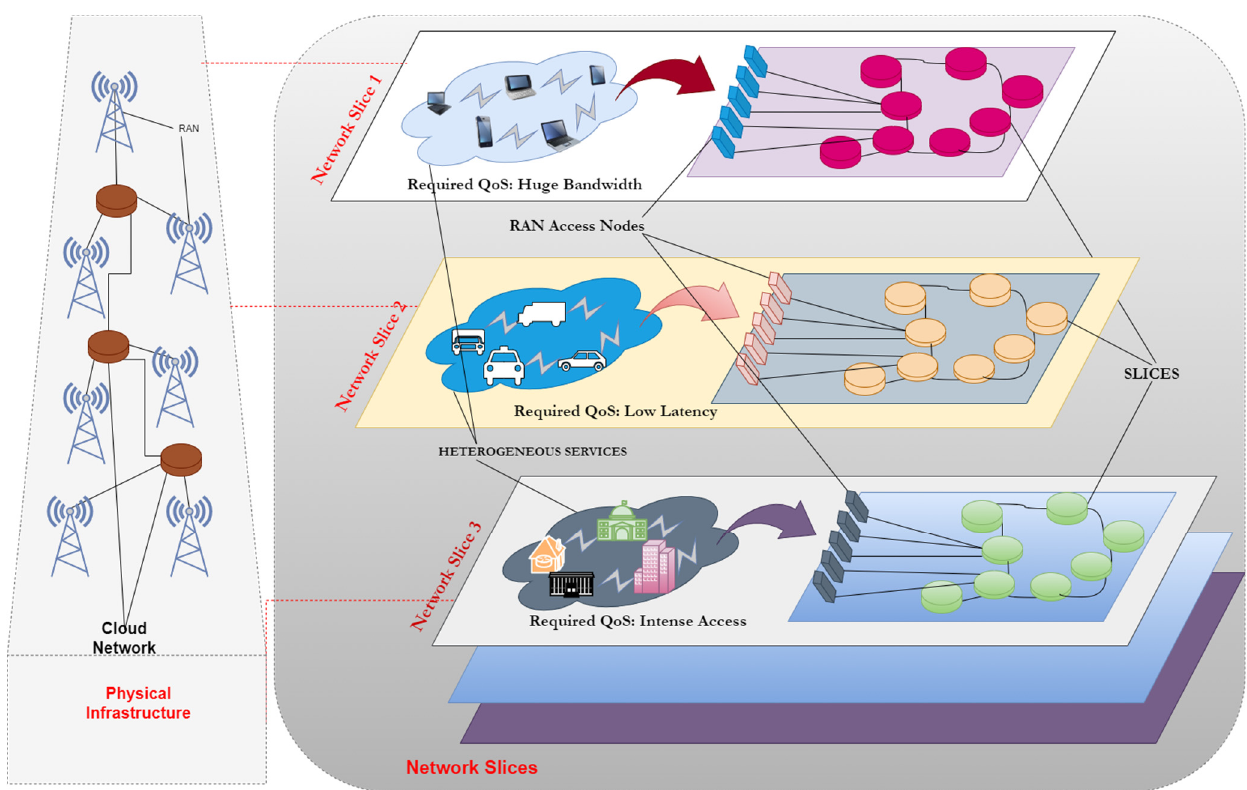
Figure 1. Network slicing scenario.